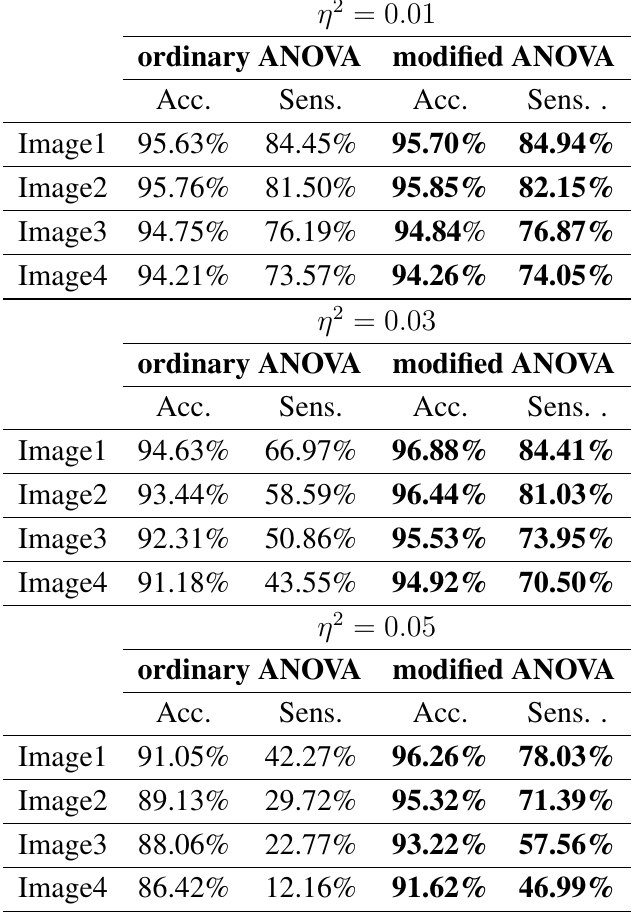
Table 2. Ordinary and modified ANOVA: sensitivity and accuracy values evaluated on the four synthetic images